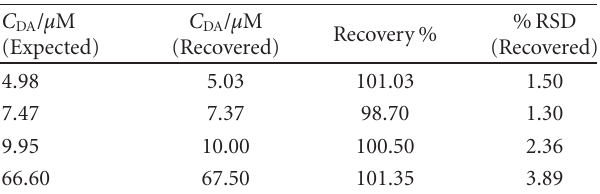
Table 3: Results of the recovery tests obtained for determination of DA in real sample (DOPADIC ampoule) after dilution to di ff erent concentrations. Results are average of four measurements on each